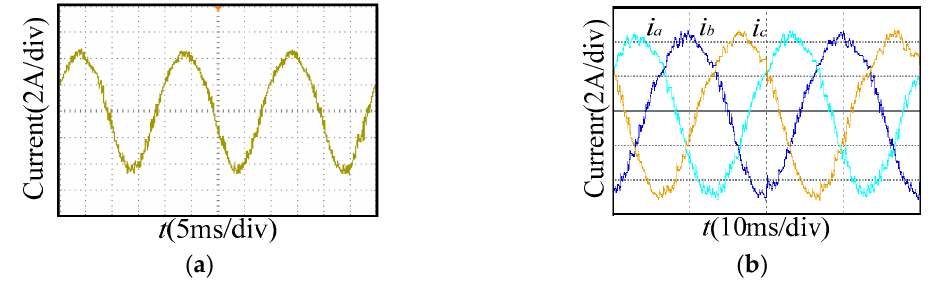
Figure 10. ( a ) Current for phase A. ( b ) Current for three phase.